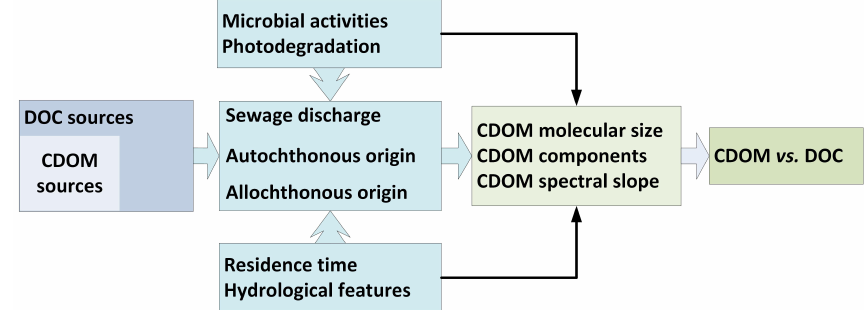
Figure 1. The potential regulating factors that influence the relationship between CDOM and DOC. Note, CDOM sources are a subset of DOC sources, and hydrological features include flow discharge, drainage area, catchment landscape, river level, and inflow or outflow